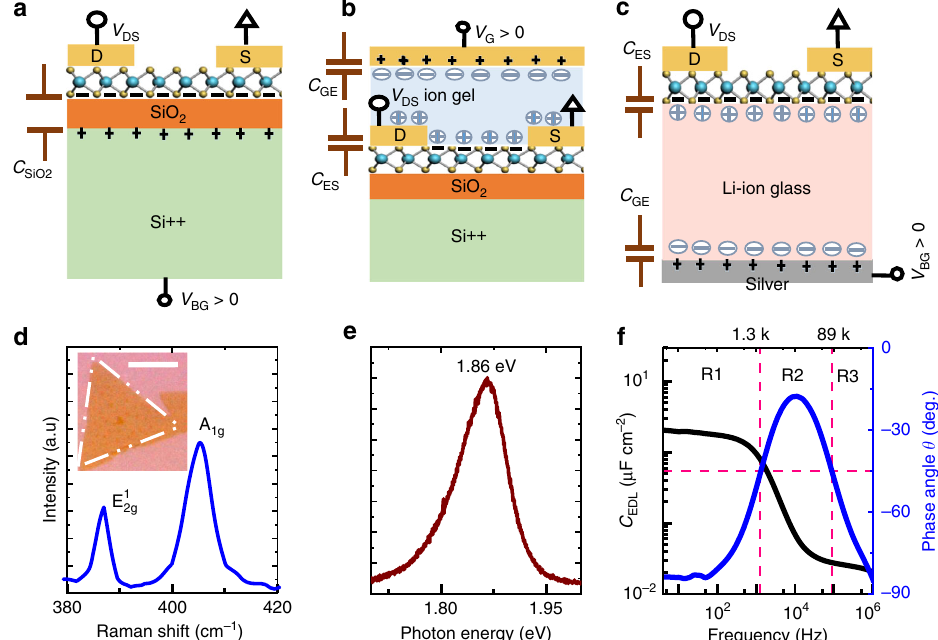
Fig. 1 Device operation, material and substrate characterization of monolayer MoS 2 on Li-ion glass. Schematic illustration of the working principle of a solid dielectric-gated FET, b ion gel-gated FET and, c Li-ion glass-gated FET. The sketches are shown for positive gate bias. The circles and the arrows in the connection schemes represent the bias and ground, respectively. d Raman spectrum of the monolayer CVD MoS 2 transferred onto glass substrate. Inset shows dark- fi eld optical micrograph of the transferred CVD MoS 2 . The boundary of the fl ake is marked with white dash-dotted lines to aid visualization. Scale bar is 10 µ m. e Photoluminescence spectrum of the same fl ake. f Capacitance/Phase angle vs. frequency of Li-ion glass substrate with Ni (20 nm) as both top and bottom electrode. The frequency spectrum can be divided into three distinct regions: (i) R1 where the EDL is formed, (ii) R2 where ion migration dominates, and (iii) R3 where the bulk Li-ion glass works as a